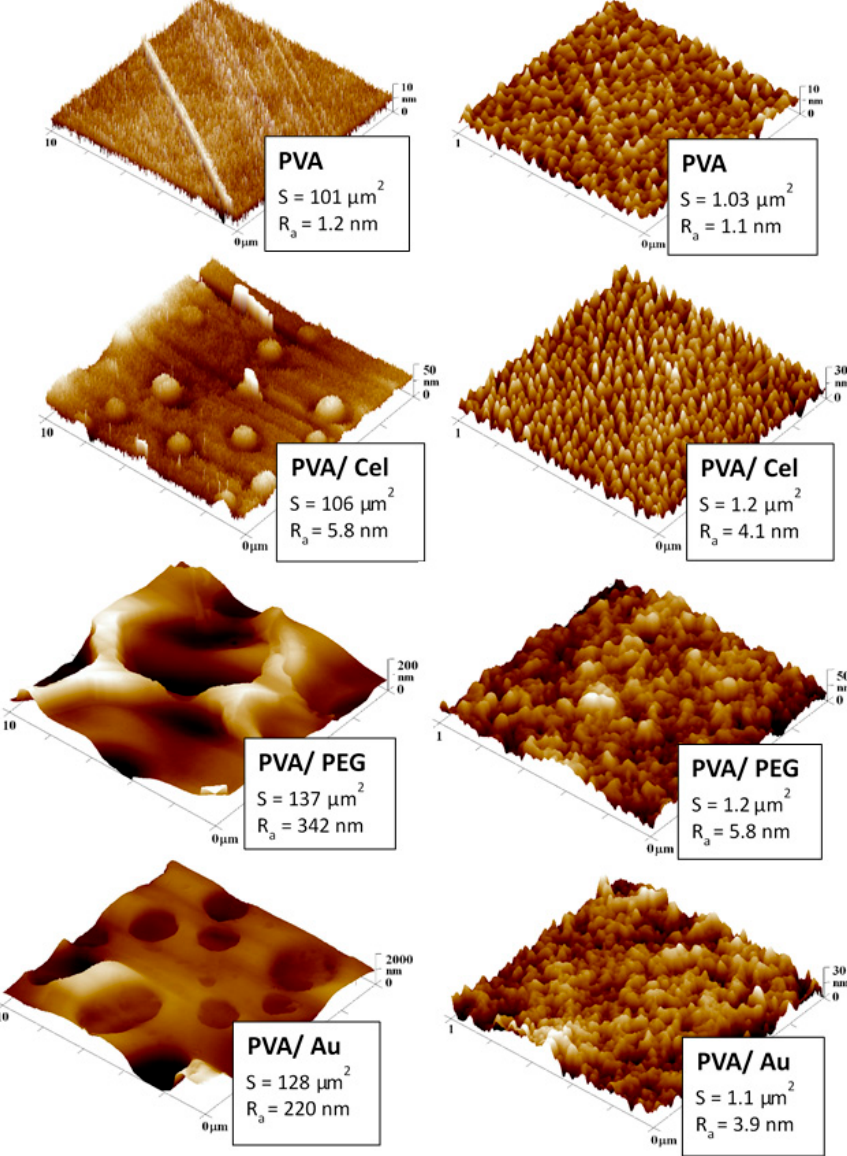
Figure 4. AFM images of plasma-treated PVA foils, which were either non-doped or were doped with cellulose (PVA/Cel), with poly(ethylene glycol) (PVA/PEG) or with Au nanoparticles in a colloid PEG solution (PVA/Au). The column on the left represents regions of 10 μ m ×10 μ m, and the column on the right represents regions of 1 μ m × 1 μ m. R a is the average surface roughness in nm, S corresponds to the effective surface area.